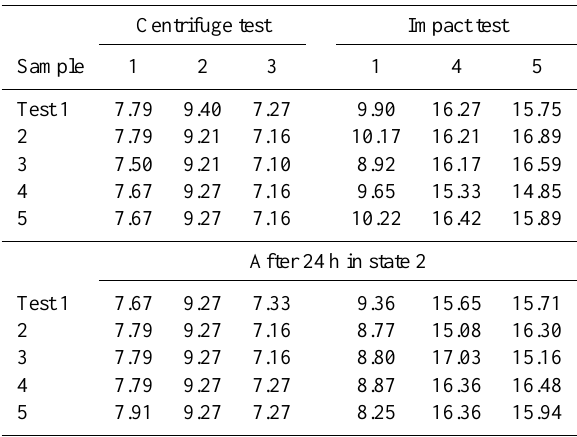
Figure 8. Pendulum and stage used to test switching accelerations under impact conditions. (a) Markers at the top of the pendulum provide an indication of drop angle. (b) This image shows the test stage where the bistable accelerometers are mounted, along with the single-axis accelerometer to measure impact accelerations. Table 1. Threshold acceleration test results for 8 ◦ configuration, reported in g’s.